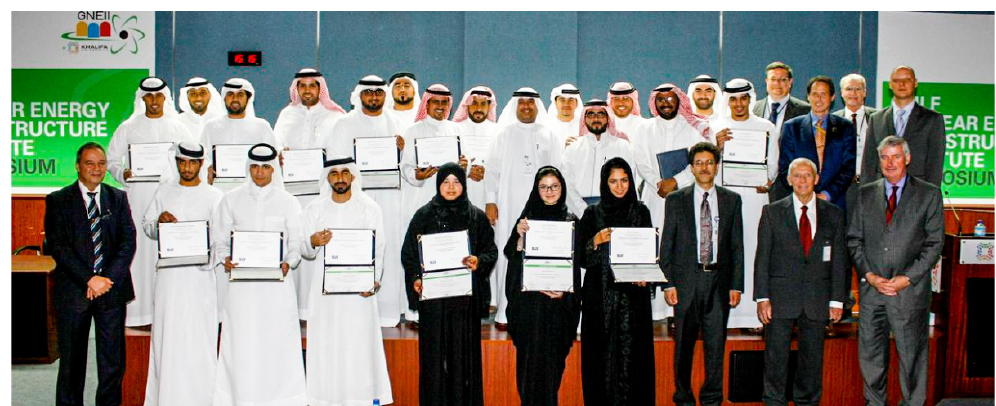
Figure 7. Group photo from GNEII graduation ceremony in 2013